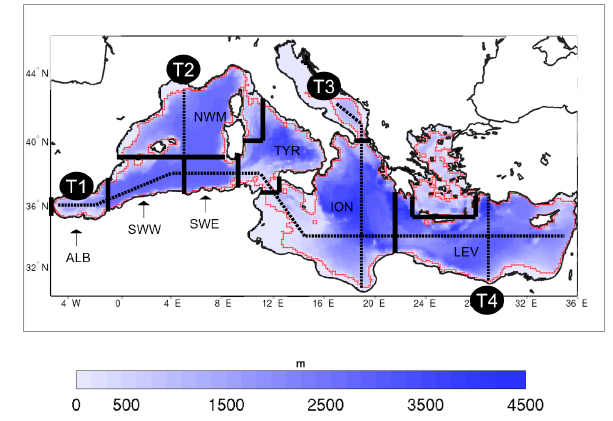
Fig. 1. Map of Mediterranean Sea bathymetry, with a-priori defined regions (delimited by solid black lines) and T1, T2, T3 and T4 tran- sects (dashed black lines). ALB = Alboran Sea, SWW = South Western Mediterranean Sea (western side), SWE = South West- ern Mediterranean Sea (eastern side), NWM = North Western Mediterranean Sea, TYR = Tyrrhenian Sea, ION = Ionian Sea, LEV = Levantine basin. Red line indicates shallow water limits (depth <